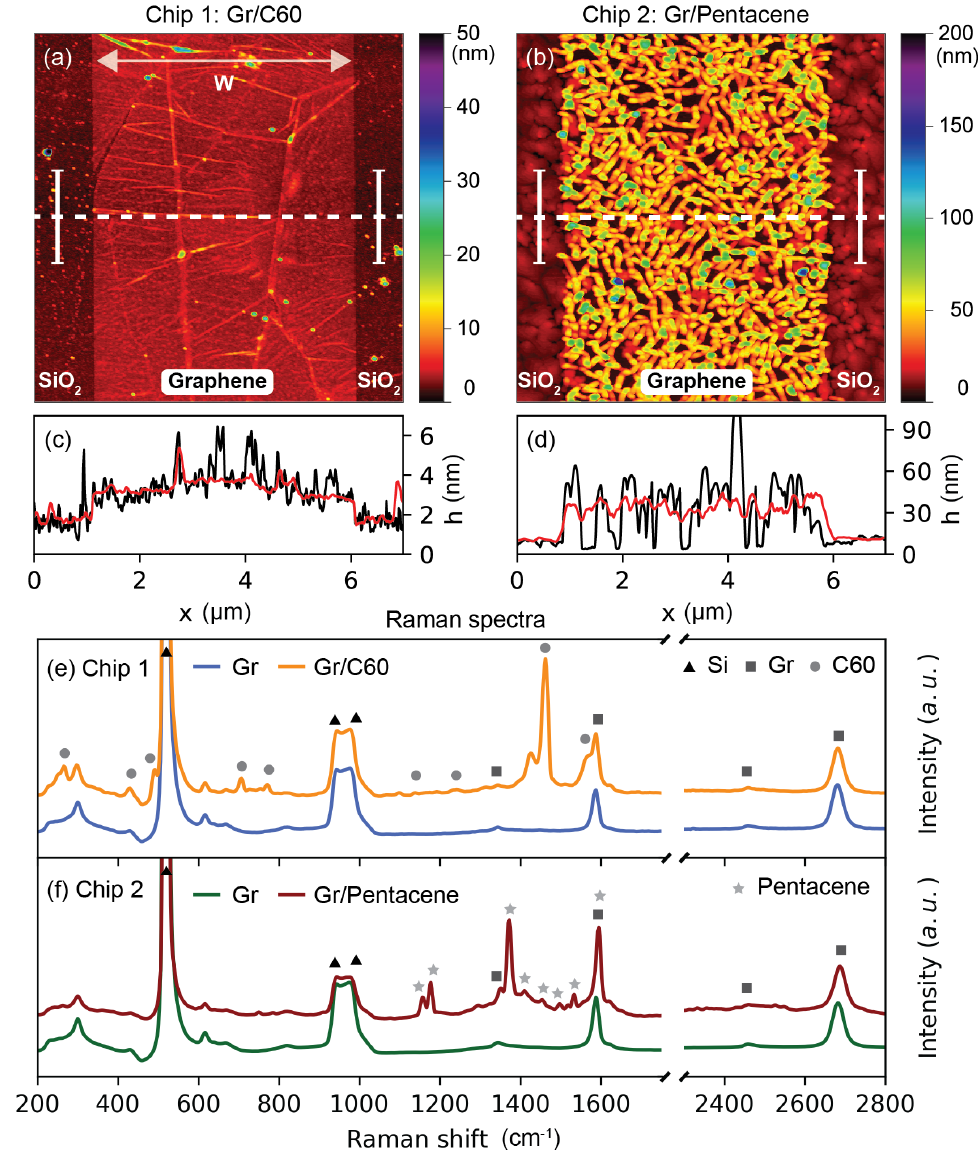
Figure 2. Surface morphology and chemical composition of the Gr/C60 (Chip 1) and Gr/Pentacene (Chip 2) heterostructures. ( a ) AFM height image of a representative Gr/C60 FET channel. ( b ) AFM height image of a representative Gr/Pentacene FET channel. ( c ) AFM height profile (black line) of the Gr/C60 FET channel taken along the dashed white line in ( a ). The red line is the mean value of 128 height profiles shown by the white bars in the AFM image. ( d ) AFM height profile (black line) of the Gr/Pentacene FET channel taken along the dashed white line in ( b ). The red line is the mean value of 128 height profiles shown by the white bars in the AFM image. ( e ) Average Raman spectra of the C60-GFETs (Chip 1). The Raman spectrum of the pristine CVD graphene is blue, while the Raman spectrum of Gr/C60 is orange. ( f ) Average Raman spectra of the Pentacene-GFETs (Chip 2). The Raman spectrum of the pristine CVD graphene is green, while the Raman spectrum of Gr/Pentacene is red. All spectra are normalized to the 2D peak of graphene. The triangle, square, circle and star symbols represent the characteristic Raman peaks of Si [30], Gr [31], C60 [32] and Pentacene [33], respectively.